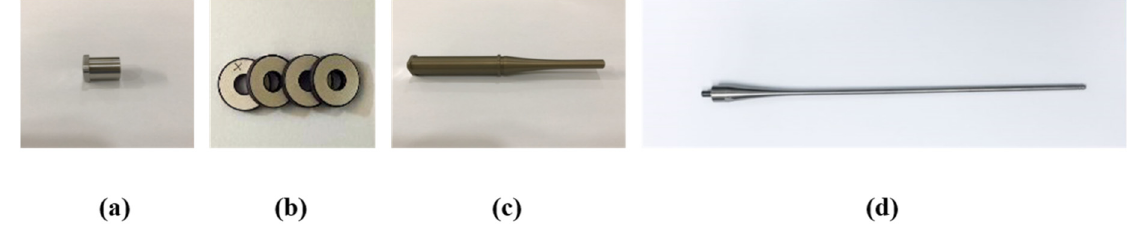
Figure 2. Transducer components: ( a ) back mass; ( b ) piezoelectric elements; ( c ) front mass; ( d ) acoustic rod.